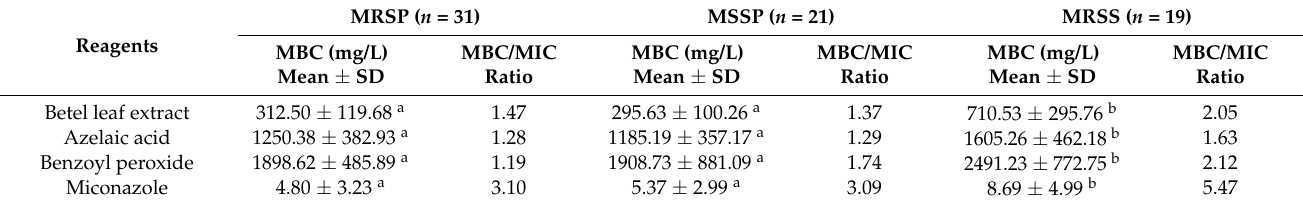
Table 3. Minimum bactericidal concentrations (MBCs) of Piper betle leaf extract, azelaic acid, benzoyl peroxide, and miconazole against methicillin-resistant Staphylococcus pseudintermedius (MRSP), methicillin-susceptible Staphylococcus pseudintermedius (MSSP), and methicillin-resistant Staphylococcus schleiferi subsp. coagulans